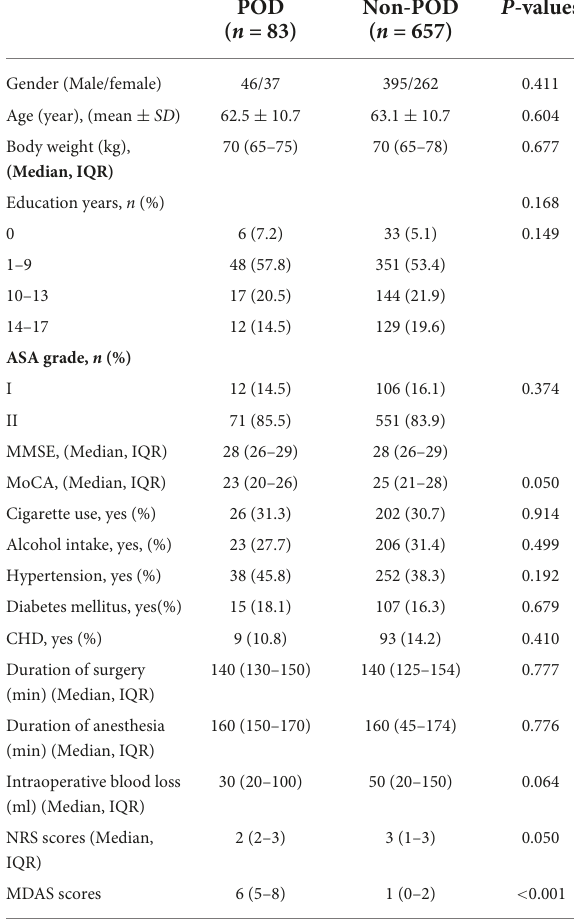
TABLE 1 Characteristics of